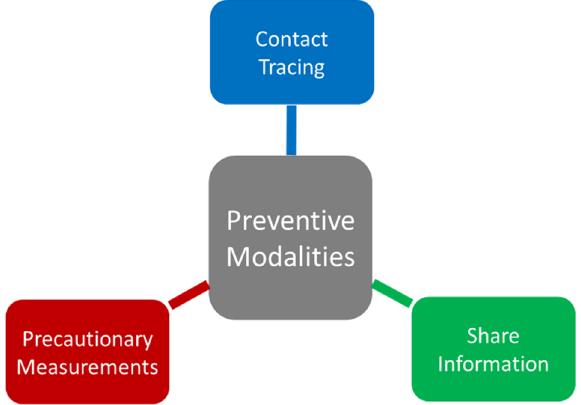
Figure 5. Three primary modes of preventive strategies to manage COVID-19 pandemic.